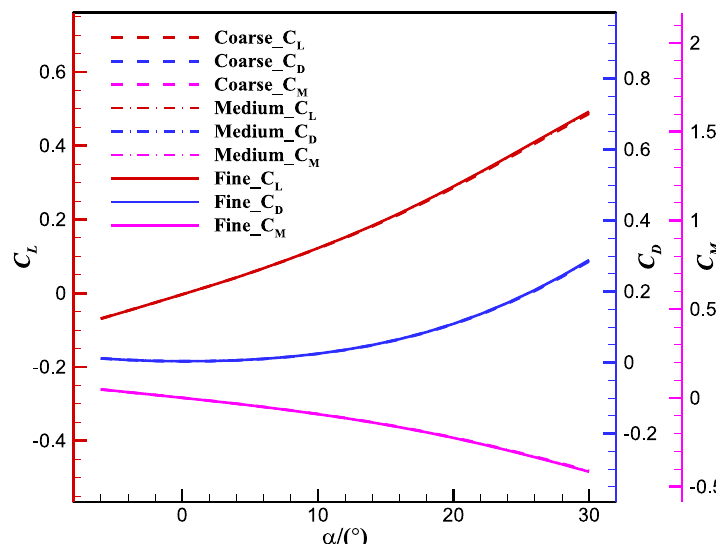
Fig. 11 Comparison of aerodynamic force coefficients calculated using the three meshes